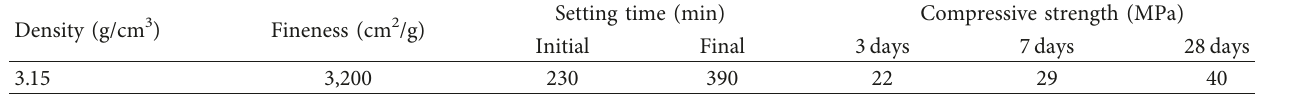
Table 3: Physical properties of cement.